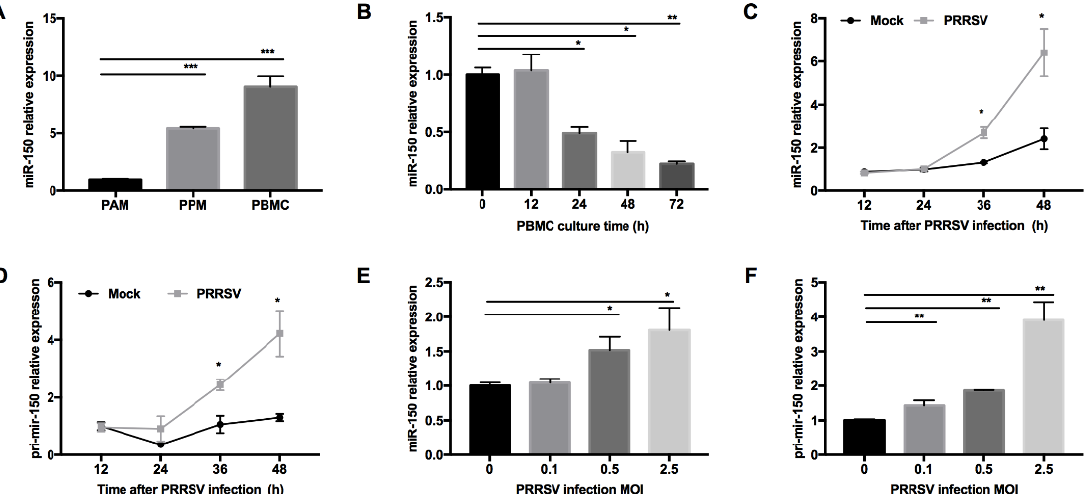
Figure 1. miR-150 expression is induced by PRRSV infection. ( A ) miR-150 expression level in PAMs, PPMs, and PBMC was analyzed by qRT-PCR. ( B ) PBMC was cultured in the presence of L929 cell culture supernatants, and total RNA was extracted at 0, 12, 24, 36, 48, and 72 h for miR-150 analysis by qRT-PCR. ( C , D ) PAMs were inoculated with medium alone or HV-PRRSV (HV isolate) at an MOI of 0.5. Total RNA was extracted at 12, 24, 36, and 48 hpi. qRT-PCR was used to analyze miR-150 and primary miR-150 expression. ( E , F ) PAMs were either mock or infected with HP-PRRSV (HV isolate) at an MOI of 0.1, 0.5, or 2.5 for 36 h, and total RNA was extracted for detecting miR-150 and primary miR-150 expression by qRT-PCR. The data are representative of three independent experiments (means ± SEM). p values were analyzed using a t -test. *, p < 0.05; **, p < 0.01; ***, p <